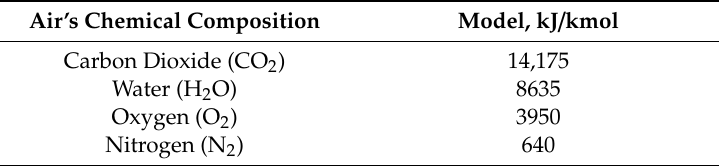
Table 5. Standard chemical exergy of chemical constituents